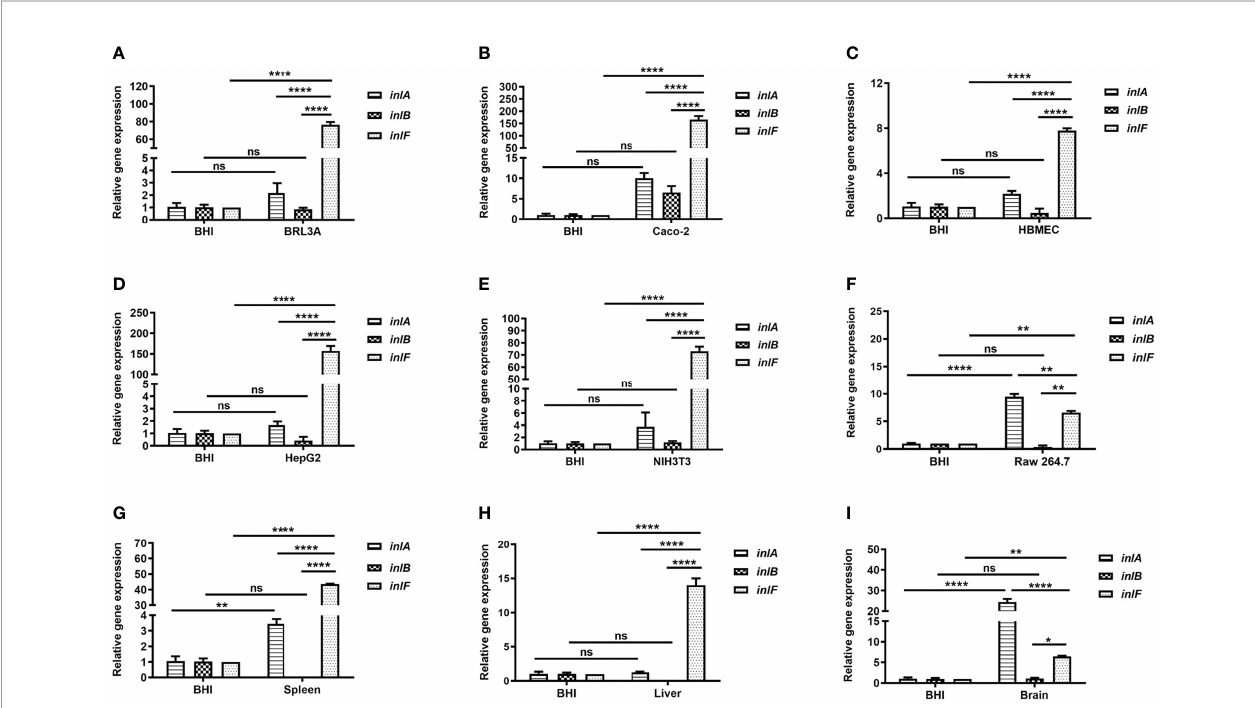
FIGURE 1 | Analysis of the transcriptional expression of internalin genes. Internalins production during Lm NTSN invasion of BRL3A (A) , Caco-2 (B) , HBMEC (C) , HepG2 (D) , NIH3T3 (E) cells was determined by qRT-PCR. The detailed description of these cells is shown in Supplementary Table 1 . Internalins expression in Lm NTSN infection of mice spleen, liver and brain is shown in (F-H) , respectively. In the experiment, six-week-old BALB/c mice were intragastrically infused at a dose of 1 × 10 9 CFU. After 72 h, RNA was extracted from the liver, spleen and brain. BHI refers to each internalin gene ’ s expression under the in vitro culture condition. Error bars represented SEM, n = 3 independent experiments. Statistical analysis was carried out by Tukey ’ s multiple comparisons test: *P < 0.05, **P < 0.01, ****P < 0.0001, ns, no signi fi